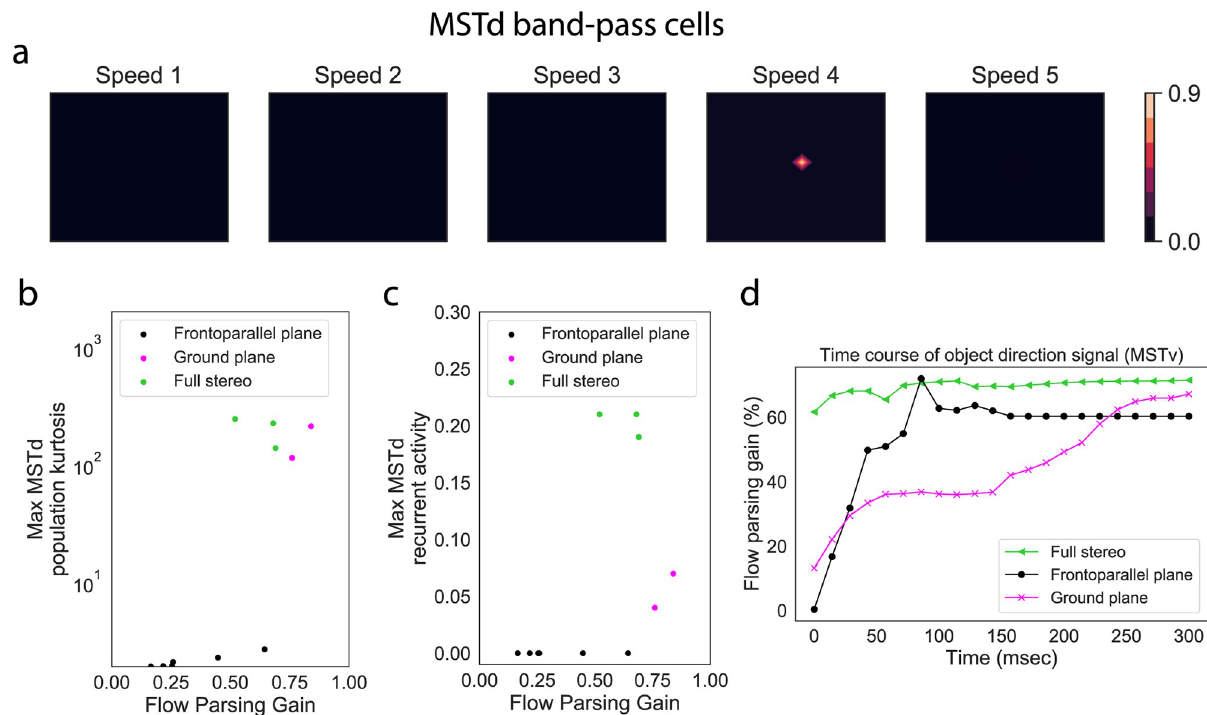
Fig 11. (a) MSTd band-pass cell activity for the Full Stereo condition. (b) Kurtosis of the most active MSTd subpopulation response, which measures the peakedness of distribution, in each simulation. (c) Strength of the recurrent signal generated by the most active MSTd subpopulation in each simulation (Eq. S21). A zero value in this panel indicates that the MSTd signal did reach the appropriate threshold to engage the recurrent mechanism. (d) Time course of the object direction signal in model MSTv. Black and blue curves reproduced from Fig